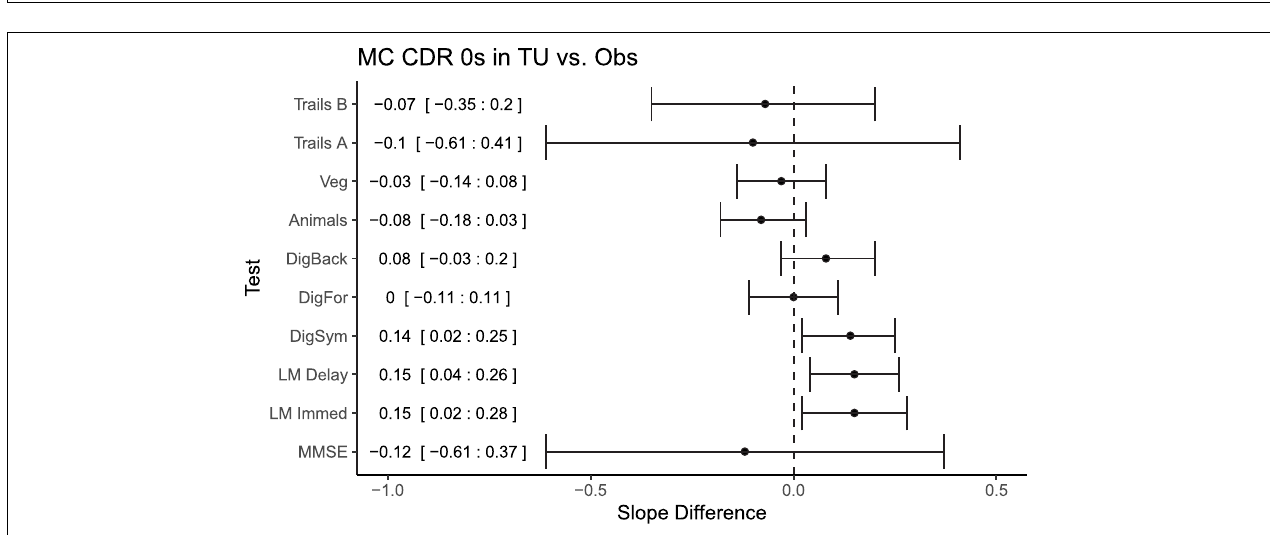
FIGURE 4 | Differences in slopes (and 95% CIs) for each test between CDR > 0 mutation carriers in TU vs. the Obs study. A positive slope difference indicates a larger or more positive slope (improvement) in the TU compared to the Obs study. Some tests, such as Logical Memory, had more improvement or practice effects in the TU vs. Obs. Mean differences and 95% CIs presented along the right side of the graph.